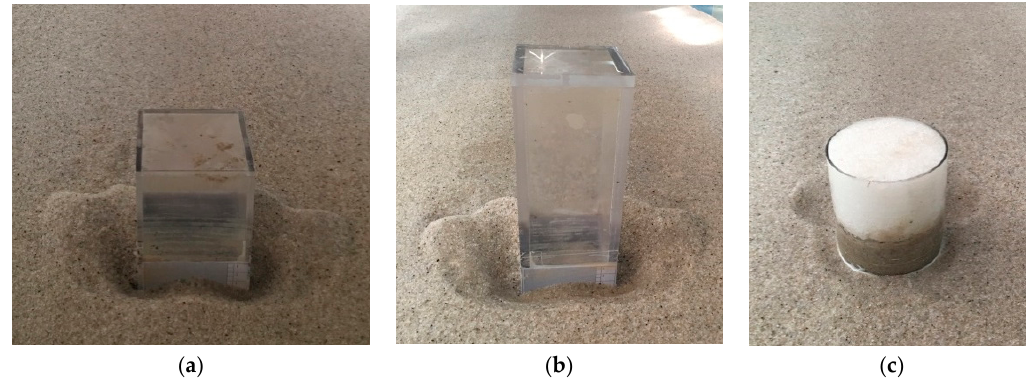
Figure 10. Photographs of scour holes after scouring. ( a ) Test 1; ( b ) Test 2; ( c ) Test 3.